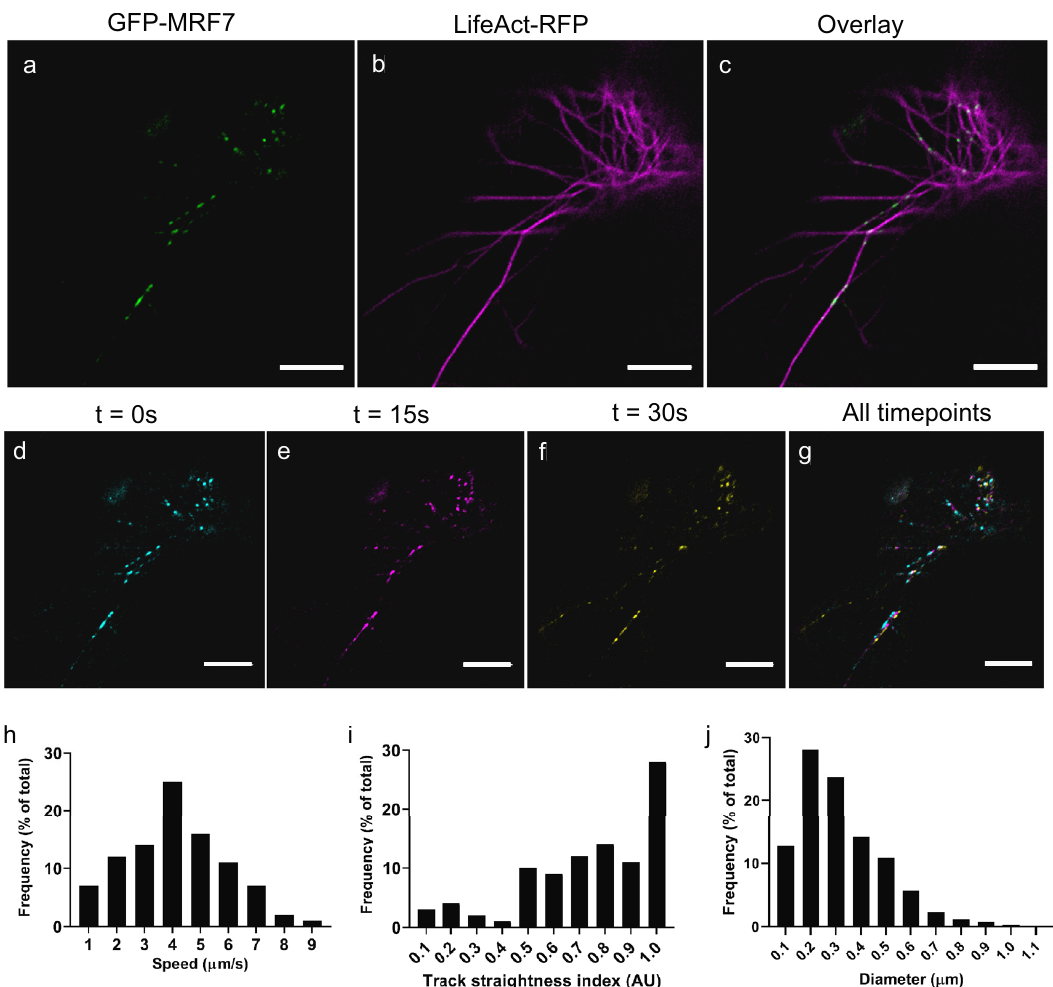
Fig. 1 GFP-MRF7 moves on discrete puncta along the actin cytoskeleton. GFP-MRF7 localises to discrete puncta in a beads-on-a-string con fi guration ( a ). Co-expression with the actin marker LifeAct-RFP ( b , c ) shows that GFP-MRF7 moves along actin tracks. The false colour timelapse images in panels d – g show the movement of GFP-MRF7 puncta: cyan ( d ), magenta ( e ) and yellow ( f ) panels represent successive still images taken at 15 s intervals. Panel g is the overlay of all timepoints: white pixels depict static regions. Distributions in panels h and i describe the movement characteristics of the GFP-MRF7 puncta, speci fi cally the frequency distributions of speed ( h ) and track straightness index ( i ) where a track straightness index of 1 indicates a straight trajectory. All images collected 2 days post-in fi ltration from tobacco leaf epidermal cells ( n = 95, 13 cells, 2 independent experiments). j Frequency distribution of the GFP-MRF7 puncta diameters measured with the Analyze Particle tool in ImageJ ( n = 689, 30 cells, 3 independent experiments). Scale bar = 10